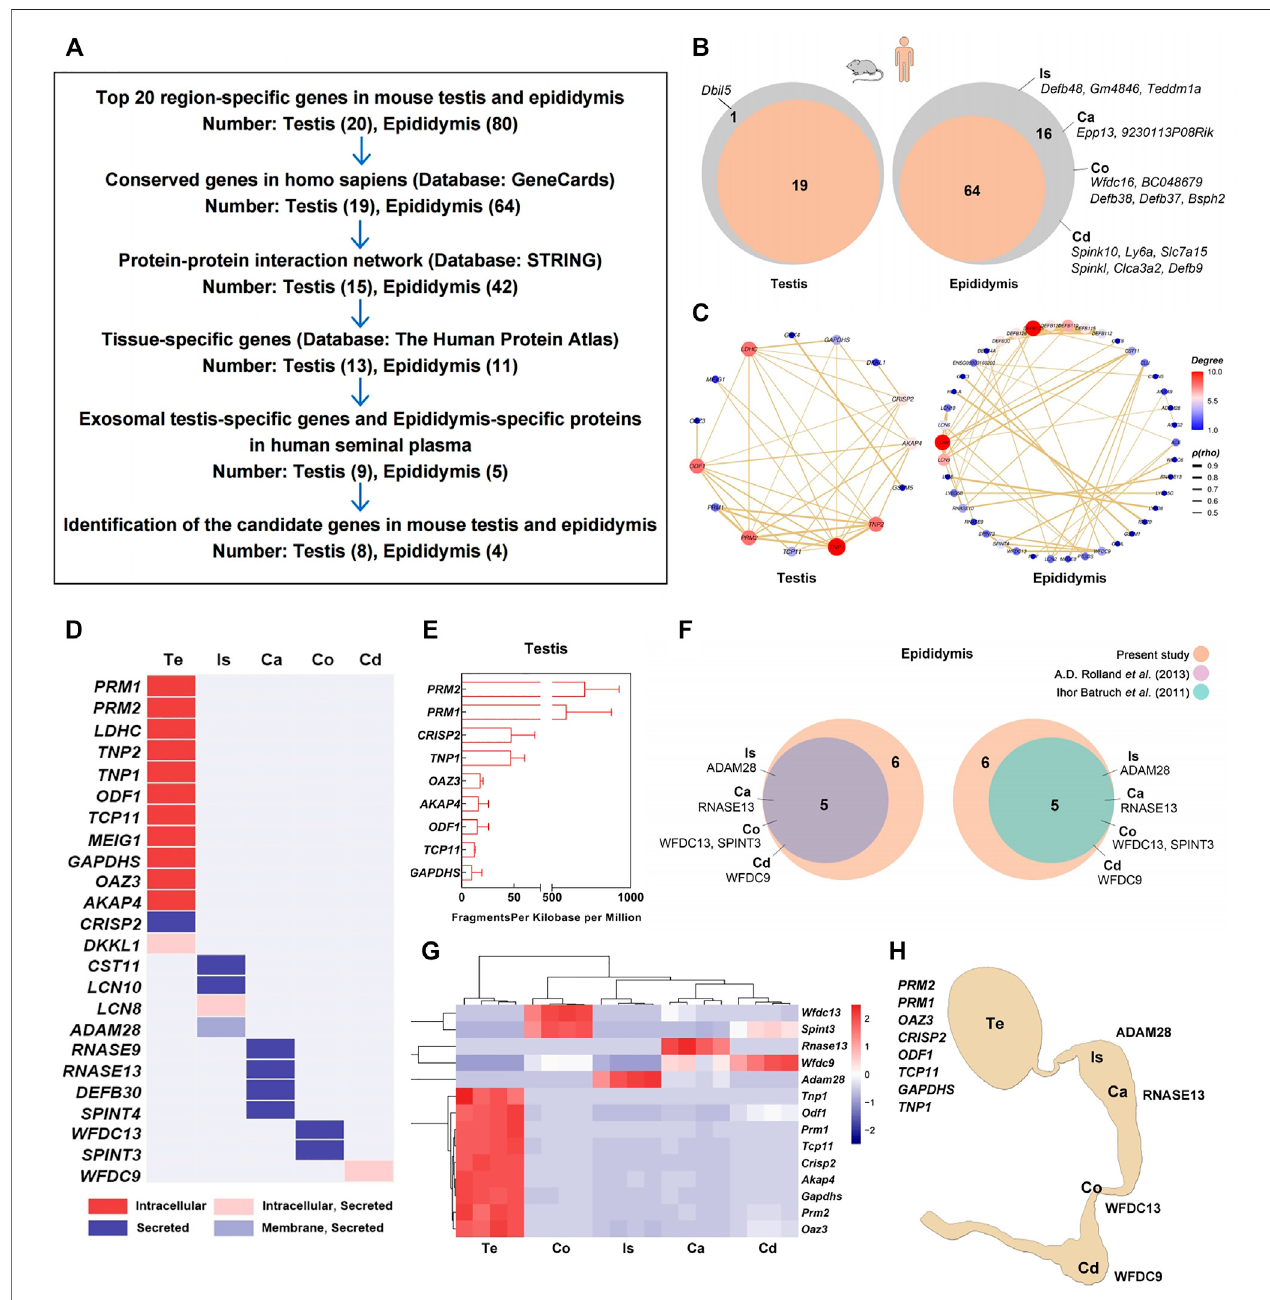
FIGURE3| Screeningandvalidationofregion-speci fi cmarkersforthetestisandepididymis. (A) Work fl owdiagramofthescreeningprocess. (B) Intotal,19testis- speci fi cand64epididymalregion-speci fi cgeneswere fi lteredfrom100region-speci fi cgenesrankedinthetop20inthese fi veregionswithconservedorthologsin Homo sapiens bysearches againsttheGeneCardsdatabase. (C) Intotal, 15and42genesplottedintheprotein-proteininteraction (PPI)networkwerefurtherpicked outusing STRING database; (D) 13 and 11 out of these 57 genes are con fi rmed with strict testis- or epididymal tissue-speci fi c expression patterns across human organs in the human protein atlas database. (E) Seminal plasma exosomes RNA-seq shows the expression of nine testis-speci fi c genes mRNA in human semen samples ( n (cid:2) 3). (F) Five epididymal region-speci fi c genes that their products identi fi ed in two previously reported proteomics of human seminal plasma. (G) Expression patterns of 14 selectedregion-speci fi cgenesaccordingtoRNA-seq. (H) Epitomeofthe12region-speci fi cgenesascandidatemarkersforthetestisandfourregionsofepididymis.Te: testis; Is: initial segment; Ca: caput; Co: corpus; Cd: cauda.